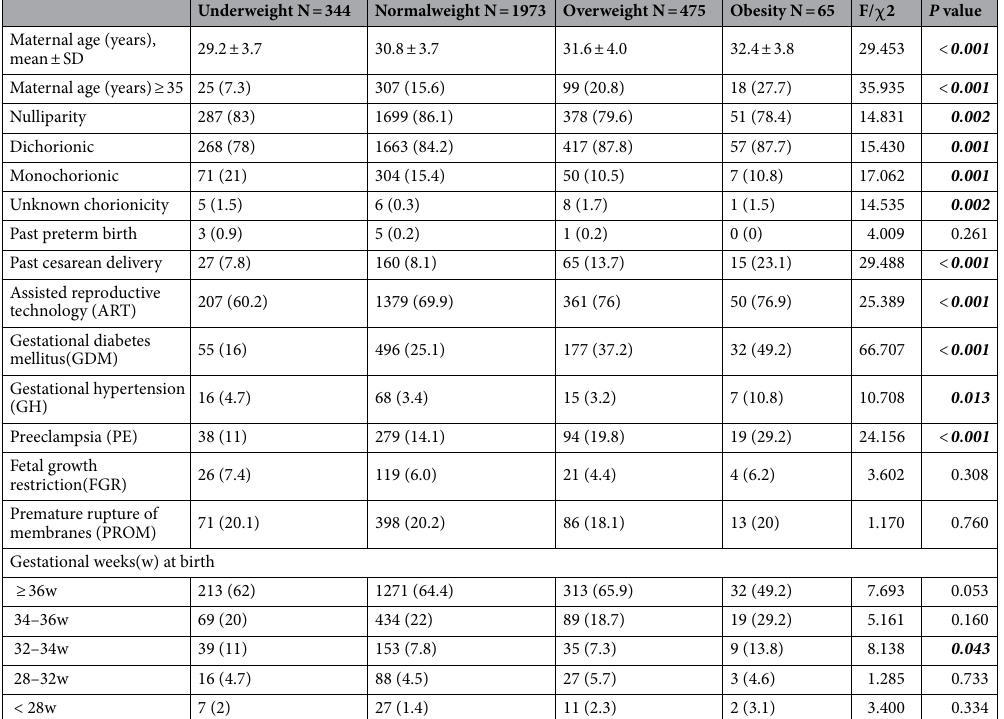
Table 1. Maternal and neonatal characteristics grouped by prepregnancy BMI. P < 0.05 was considered statistically significant. Significant values are in [bolditalics].